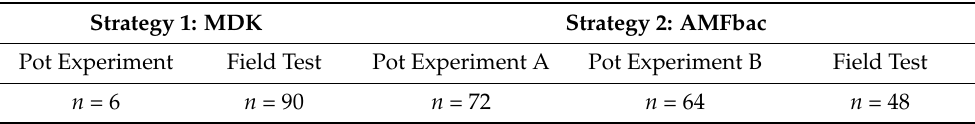
Table 1. Test methodology for proof-of-concept and on-farm field